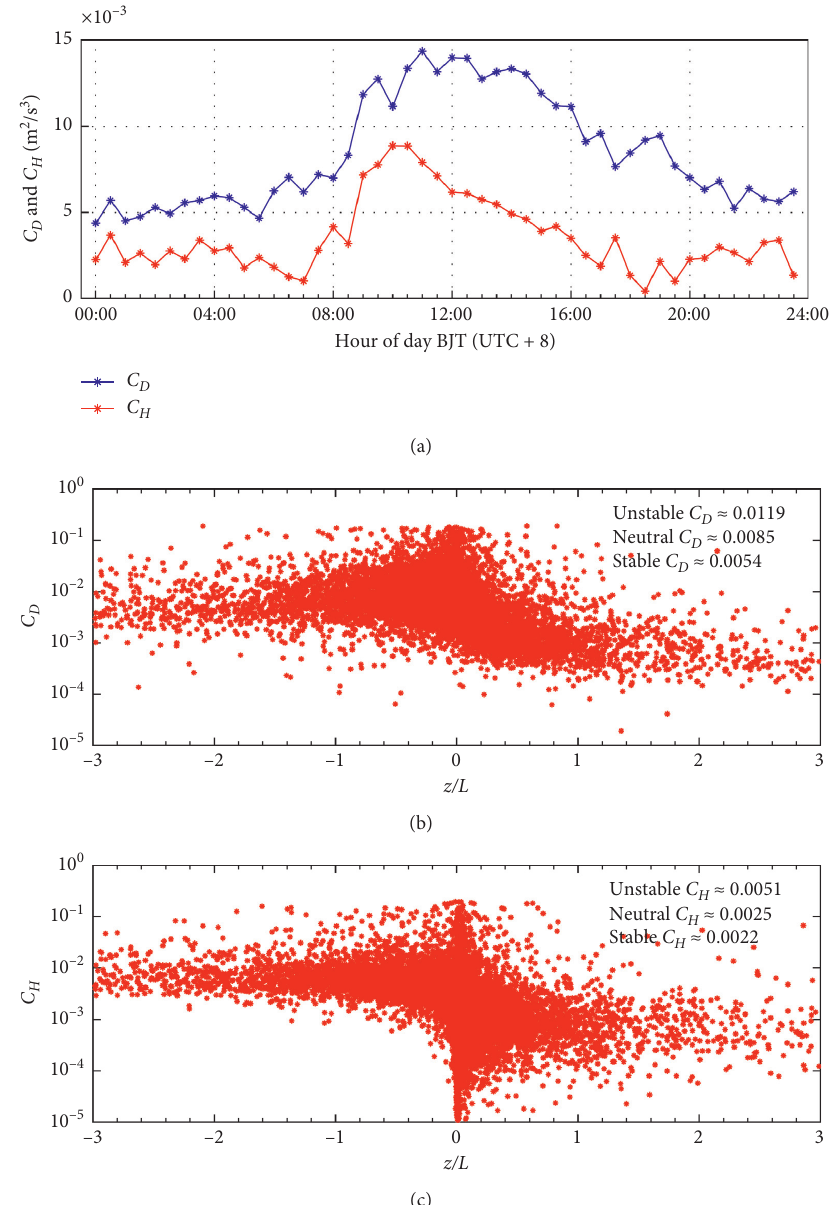
Figure 8: Diurnal variation of the bulk transfer coefficient and its distribution with stability. (a) The diurnal variation of the bulk transfer coefficient. (b, c) The distribution of the momentum and heat bulk transfer coefficient with stability, respectively.